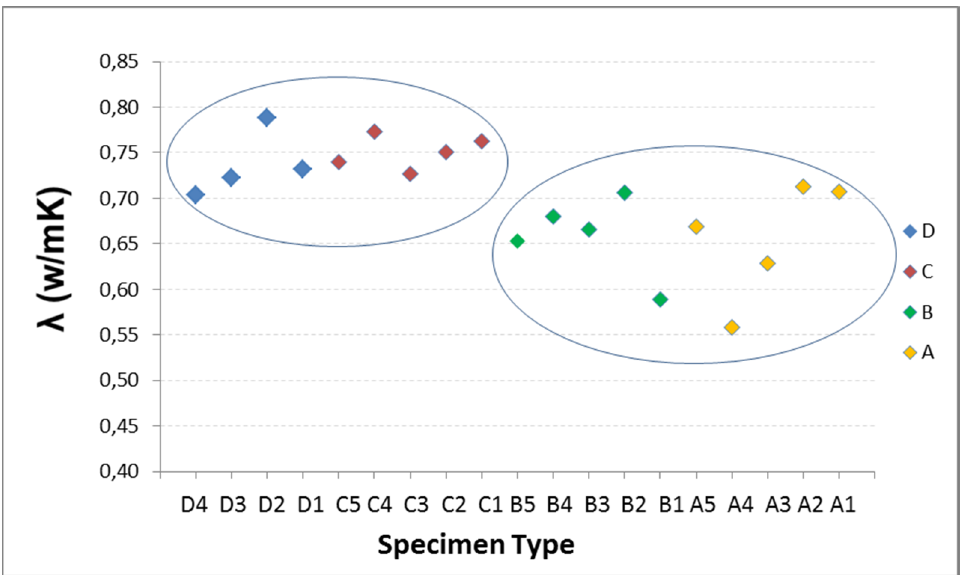
Figure 8. Influence of recycled aggregate percentage on thermal conductivity at 20